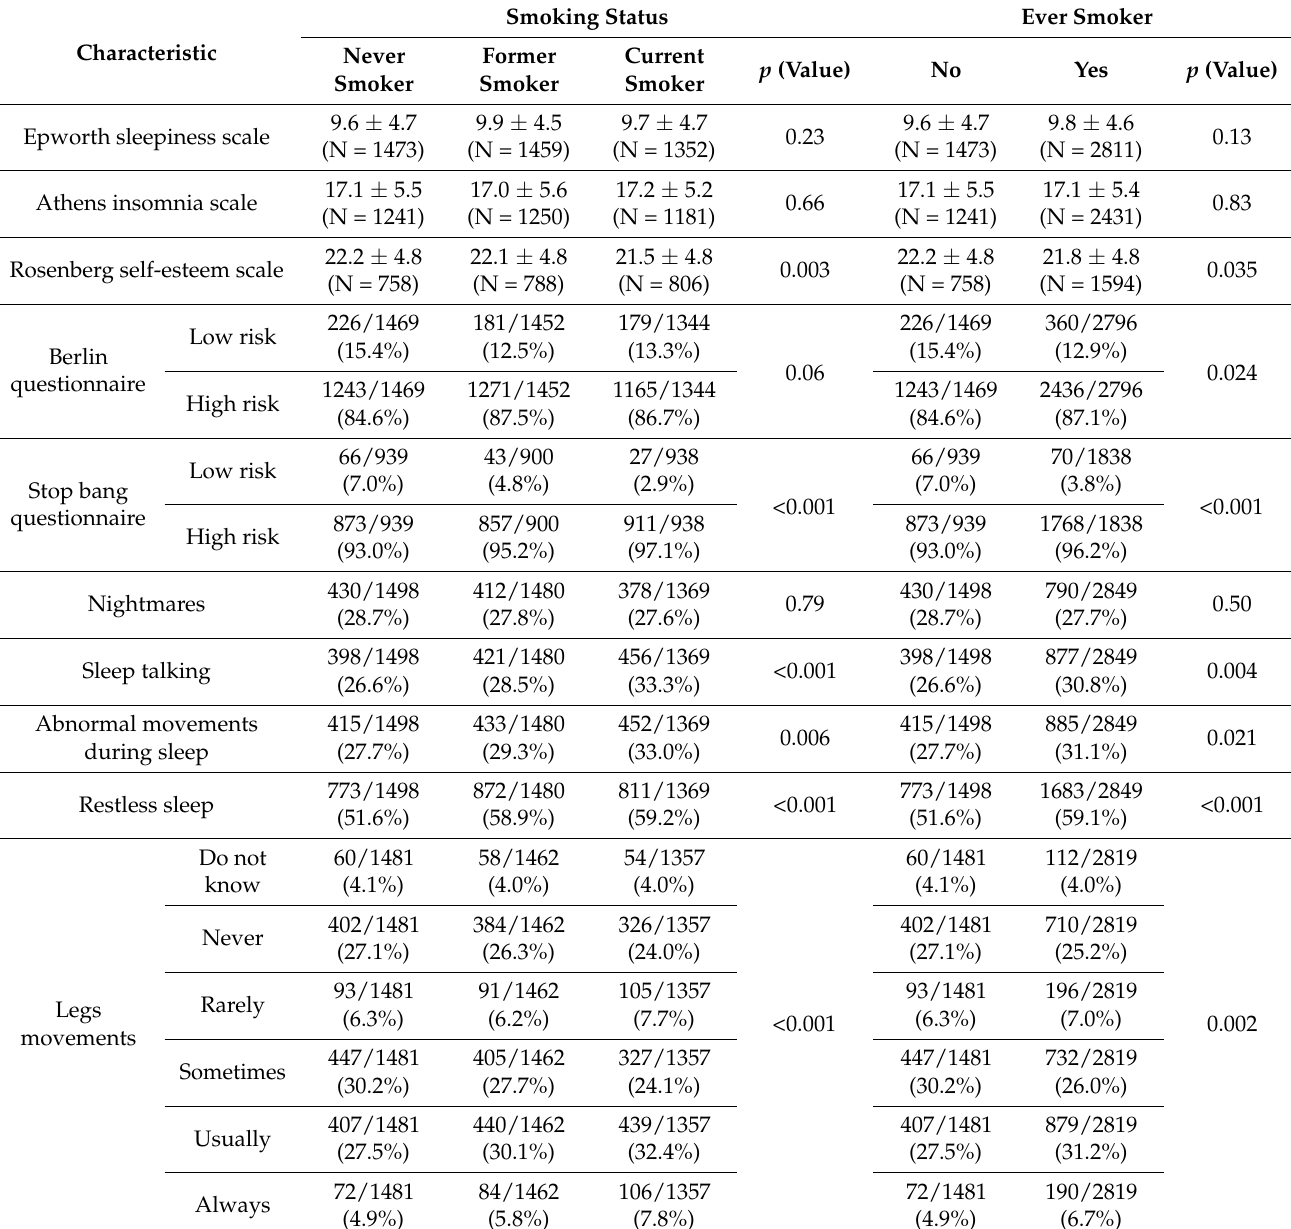
Table 3. Sleep symptoms and sleep questionnaires according to the smoking status of the